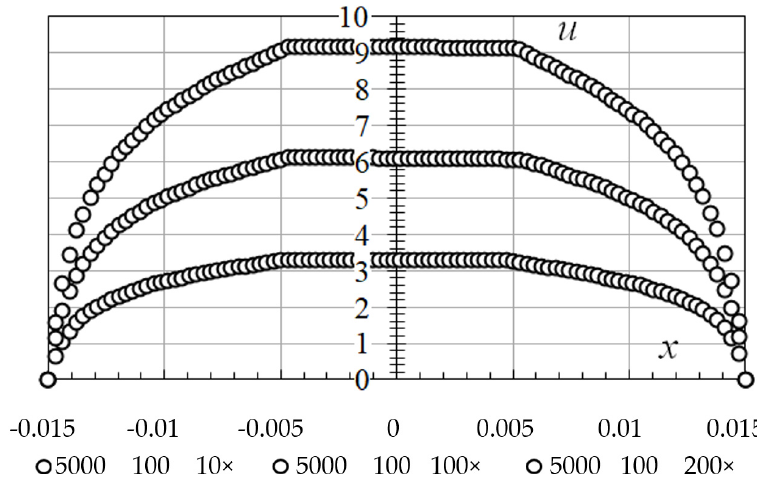
Figure 4. Air velocity profiles in the horizontal central-section of ZOX at 100 kg/h ( x [m], u [m/s]), bottom-up curves, respectively: 10×; 100×; 200×.